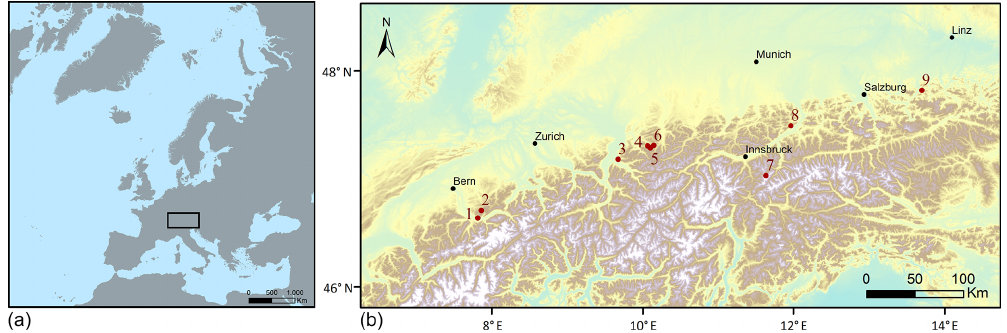
Figure 1. Map of cave sites discussed in text. 1. St. Beatus cave; 2. Siebenhengste cave; 3. Große Baschg cave; 4. Schneckenloch cave; 5. Klaus Cramer cave; 6. Hölloch cave; 7. Kleegruben cave (part of wider discussion on isotopic controls); 8. Grete–Ruth shaft; 9. Gassel cave. The generalised map (a) is produced with EuroGeographics and UN-FAO GI data; city locations (b) are taken from the Urban Audit, 2004 – European Commission, Eurostat/GISCO data set; the digital elevation model (b) is produced using Copernicus data and information funded by the European Union – EU DEM